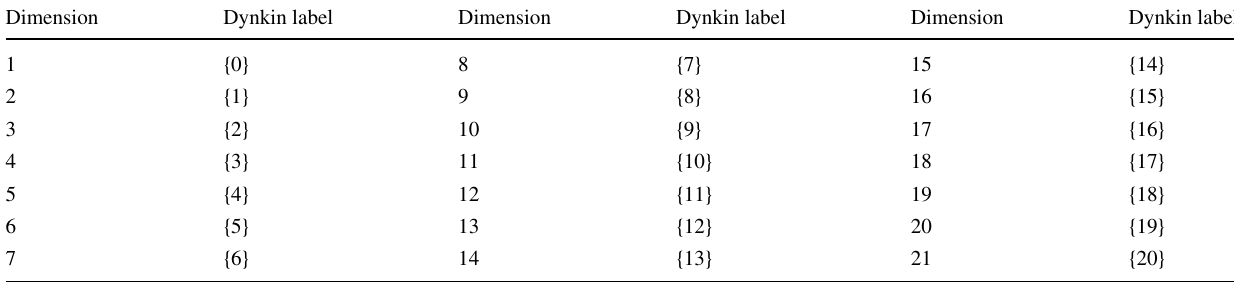
Table 57 Dynkin labels corresponding to a few low dimensional representations of SU ( 2 )